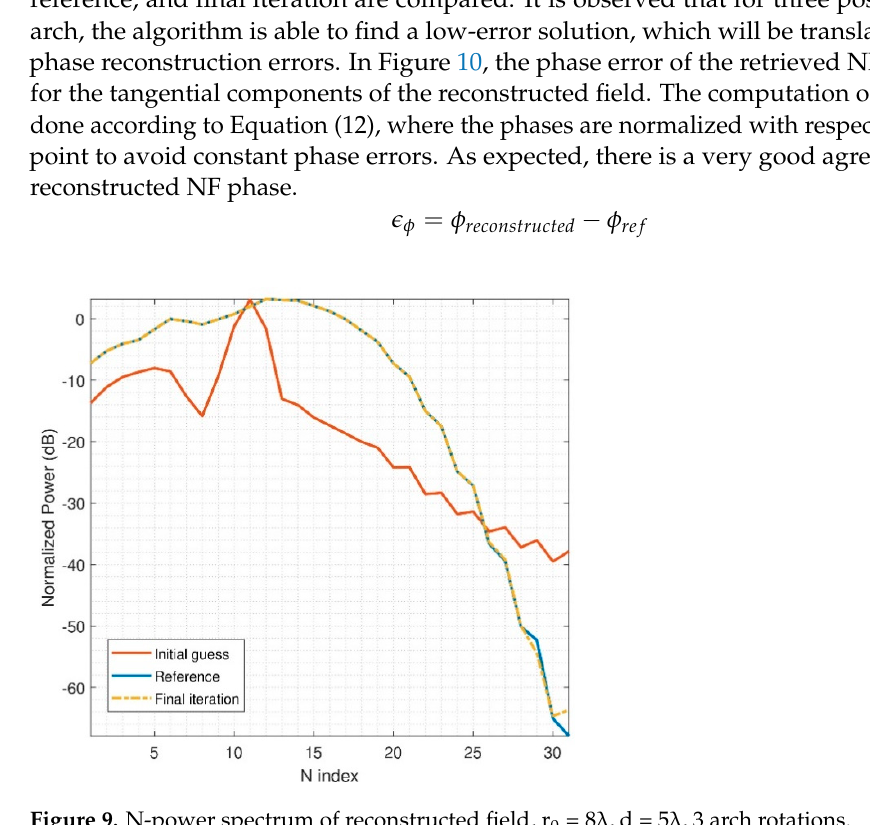
λ , d = 5 λ , 3 arch rotations. 0 = 8